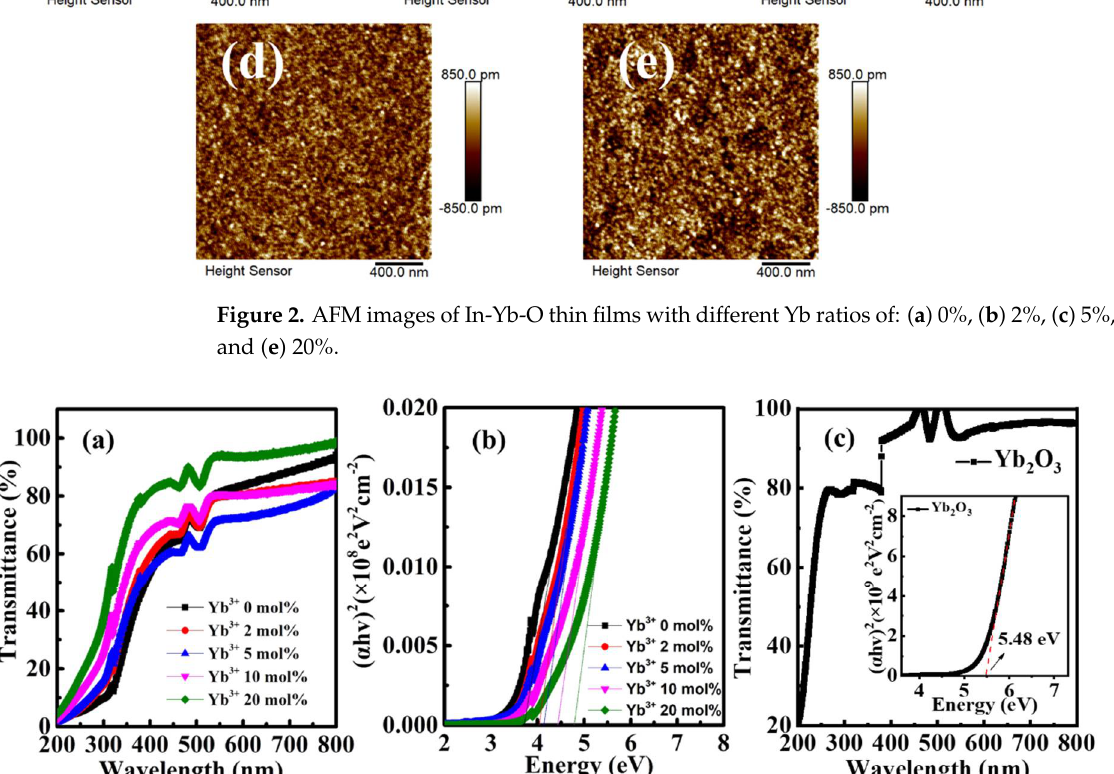
Figure 2. AFM images of In-Yb-O thin films with different Yb ratios of: ( a ) 0%, ( b ) 2%, ( c ) 5%, ( d ) 10%, and ( e ) 20%.